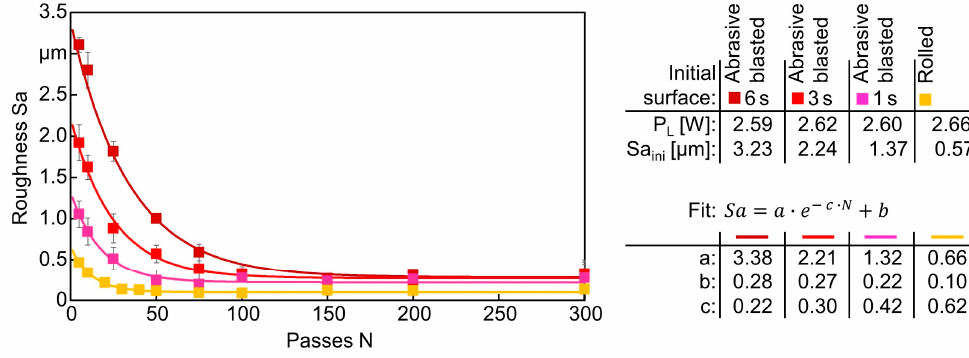
Figure 6. Roughness of the rolled and abrasive blasted surfaces after multiple passes and their exponential fit parameter.